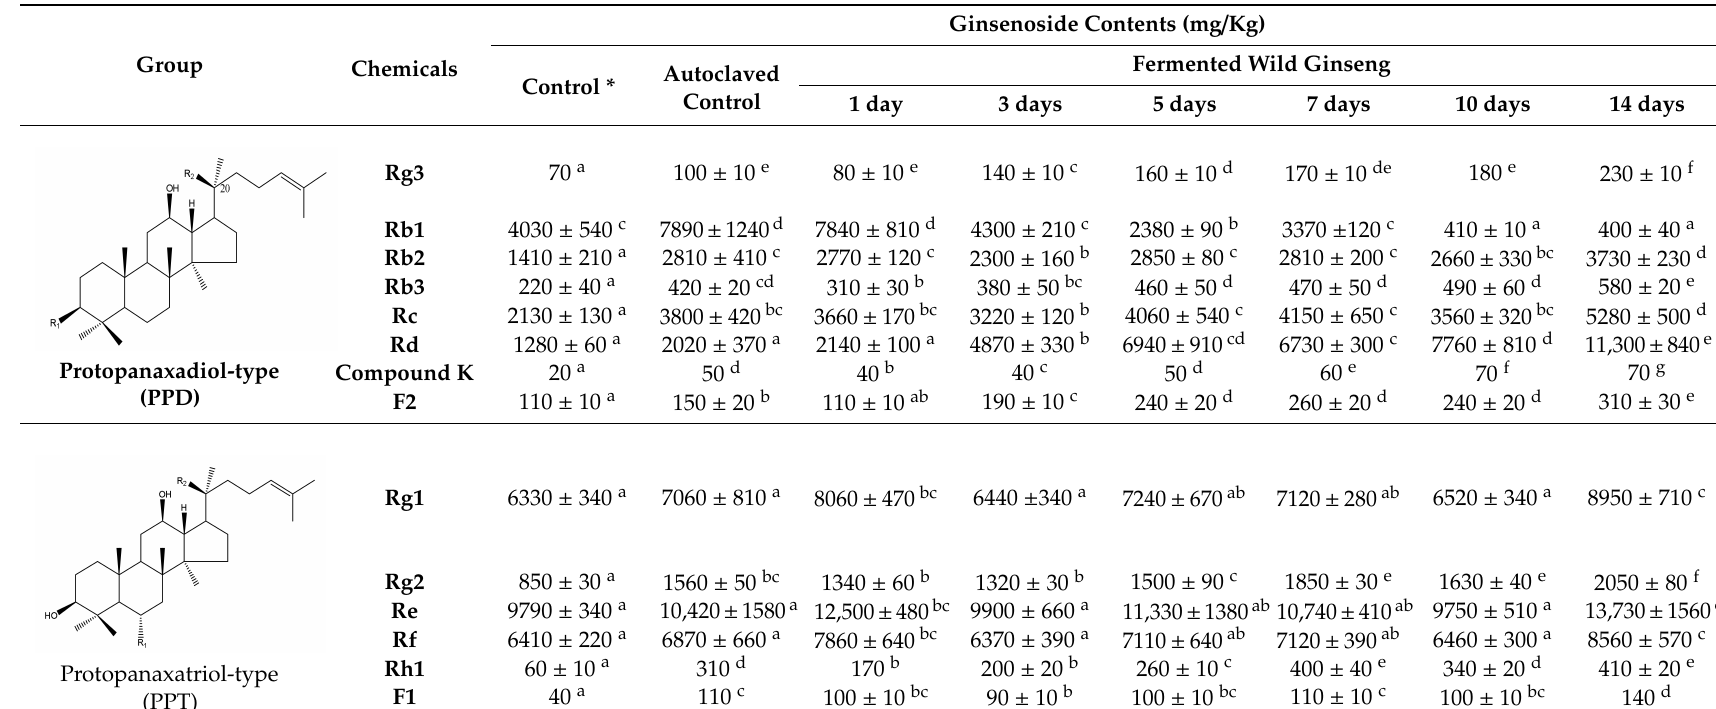
Table 2. Ginsenoside contents in the fermented wild ginseng following R. oligosporus